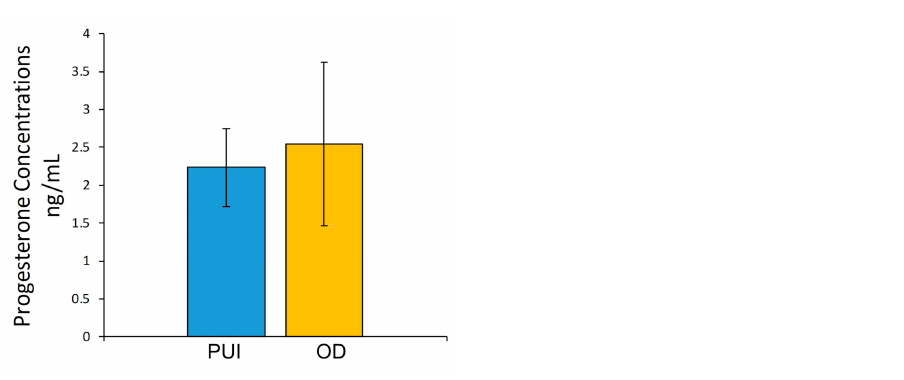
Figure 1. Serum P4 concentrations (ng/mL) immediately before C-section in bitches with primary uterine inertia (PUI) and obstructive dystocia (OD). Results presented as mean ± SD.